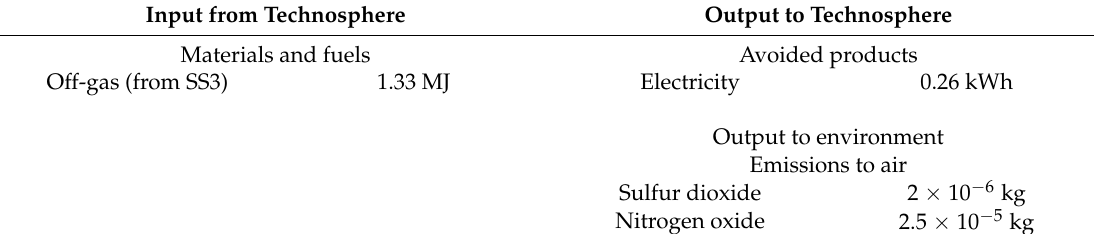
H2 ) for Subsystem 4.